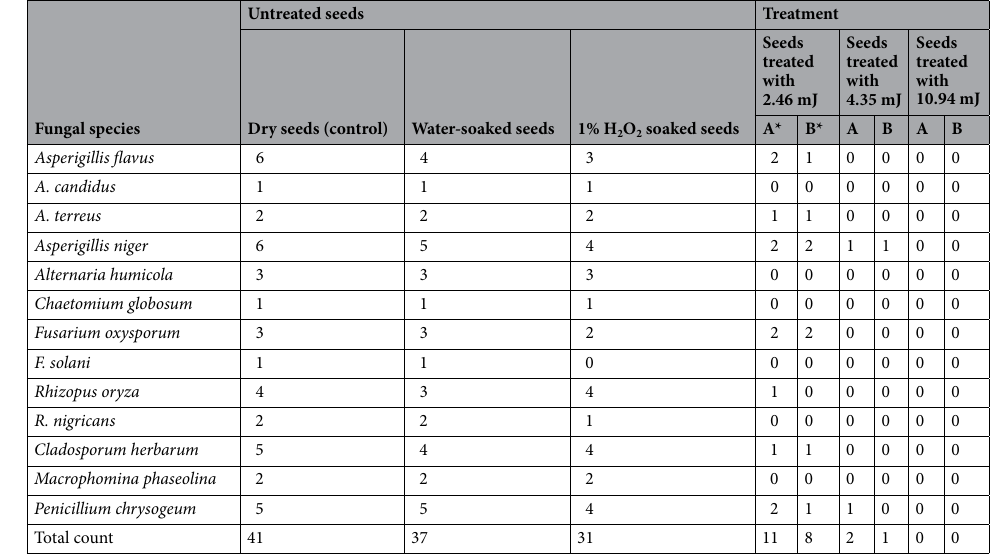
Table 1. Effect of cold atmospheric plasma on seedborne fungi associated with Moringa oleifera (colony/10 g dry seeds). *A = Seeds soaked in water, B = seeds soaked in 1% H 2 O 2 .